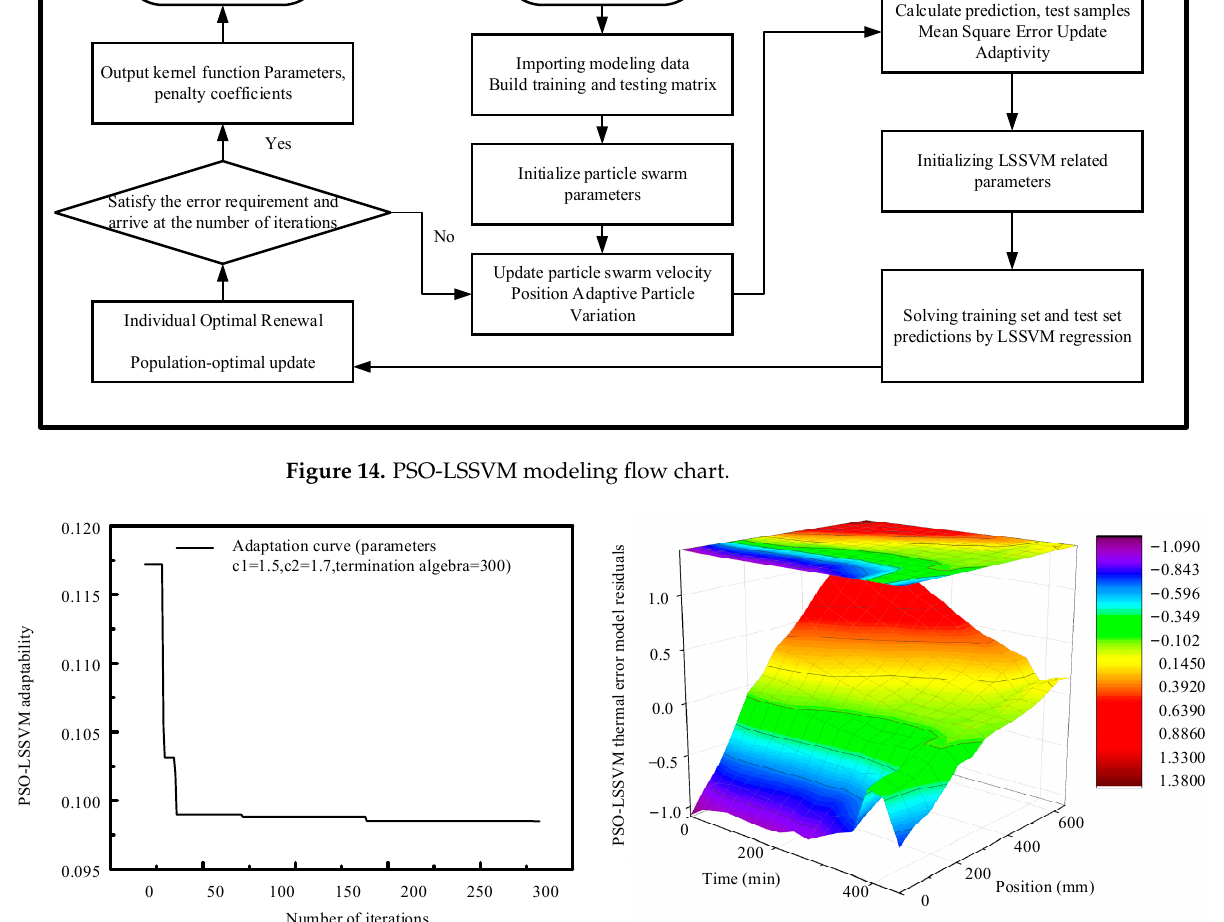
of the selected test samples fluctuates from [ − 1.090 μ m to 1.380 μ m]. The PSO-LSSVM